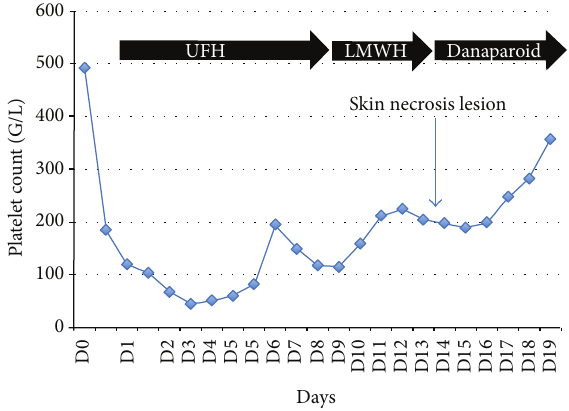
Figure 2: Timeline of platelets count and anticoagulant therapies. Skin necrosis appeared on day 15. Platelet count increased after danaparoid initiation. UFH: unfractionated heparin; LMWH: low molecular weight heparin; RRT: renal replacement therapy.